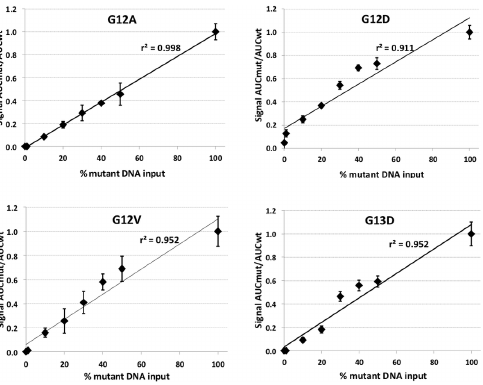
doi:10.1371/journal.pone.0153278.g002